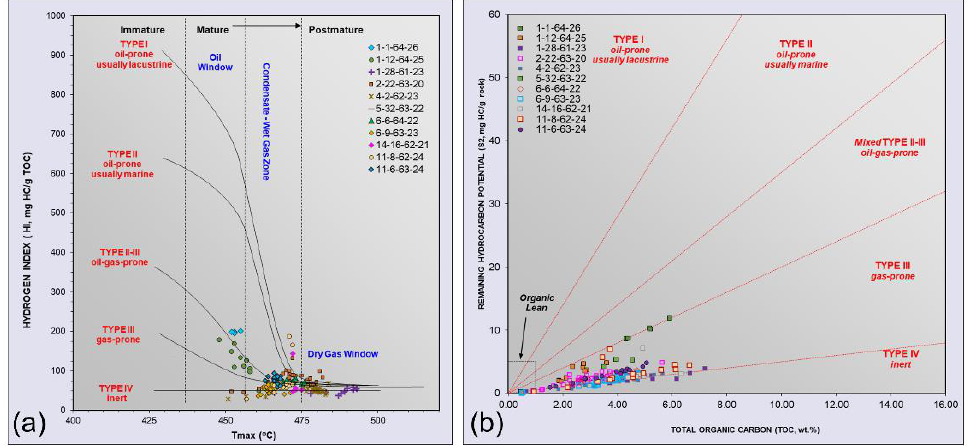
Figure 10. Geochemistry features of coring wells [38]. ( a ) Relationships between the Tmax and Hydrogen Index. ( b ) Relationship between TOC and S2.